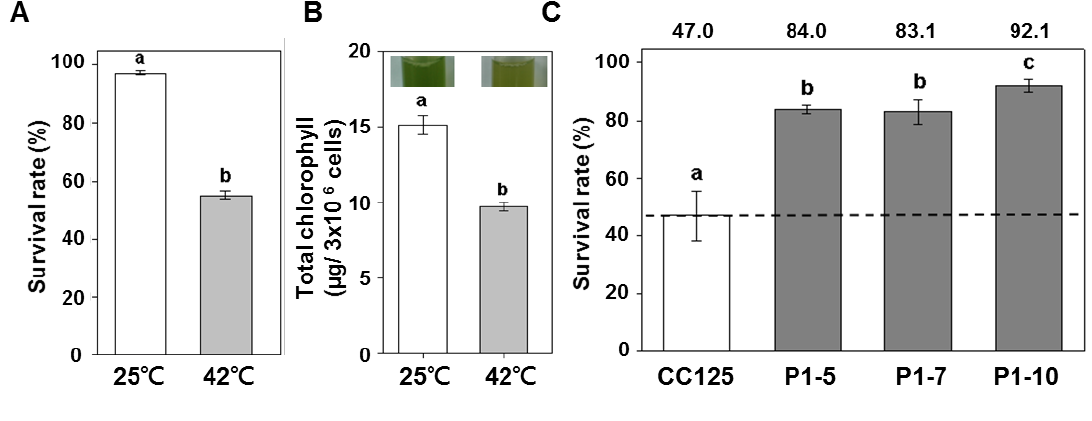
Figure 3. Impact of heat stress on survival rates and chlorophyll contents in Chlamydomonas overexpressing PETF . ( A ) Survival rate of Chlamydomonas CC125, after a 2 day recovery from heat treatment at 42 °C for 40 min; ( B ) Chlamydomonas cell cultures were imaged, and the total chlorophyll contents were measured immediately after heat treatment; ( C ) Survival rate comparison between non-transformant and PETF overexpression lines after heat treatment. The heat-treated cell cultures were incubated under normal growth conditions for 72 h prior to measuring the survival rate. Then the survival rates of the non-transgenic CC125 and transgenic lines (P1-5, P1-7, and P1-10) were measured using trypan blue staining, and the cell count of CC125 without heat treatment was determined to be 100%. Error bars indicate standard deviations of the mean for five repeats of each line, and letters indicate the significant differences based on Duncan’s multiple range test ( p <